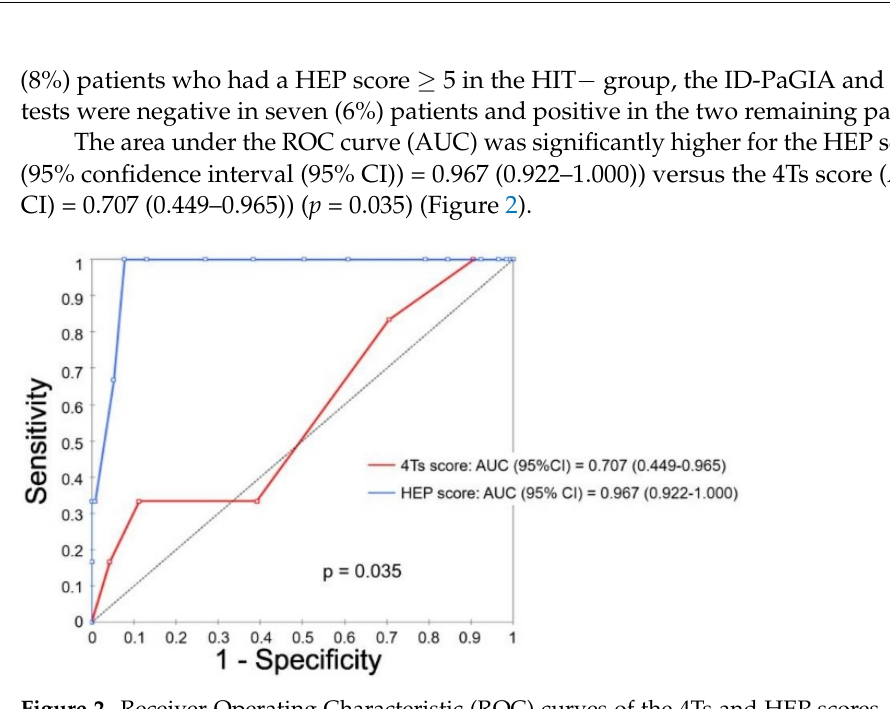
Figure 2. Receiver Operating Characteristic (ROC) curves of the 4Ts and HEP scores. HEP score: Heparin-induced thrombocytopenia Expert Probability score. AUC: area under the ROC curve. 95% CI: 95% confidence interval.